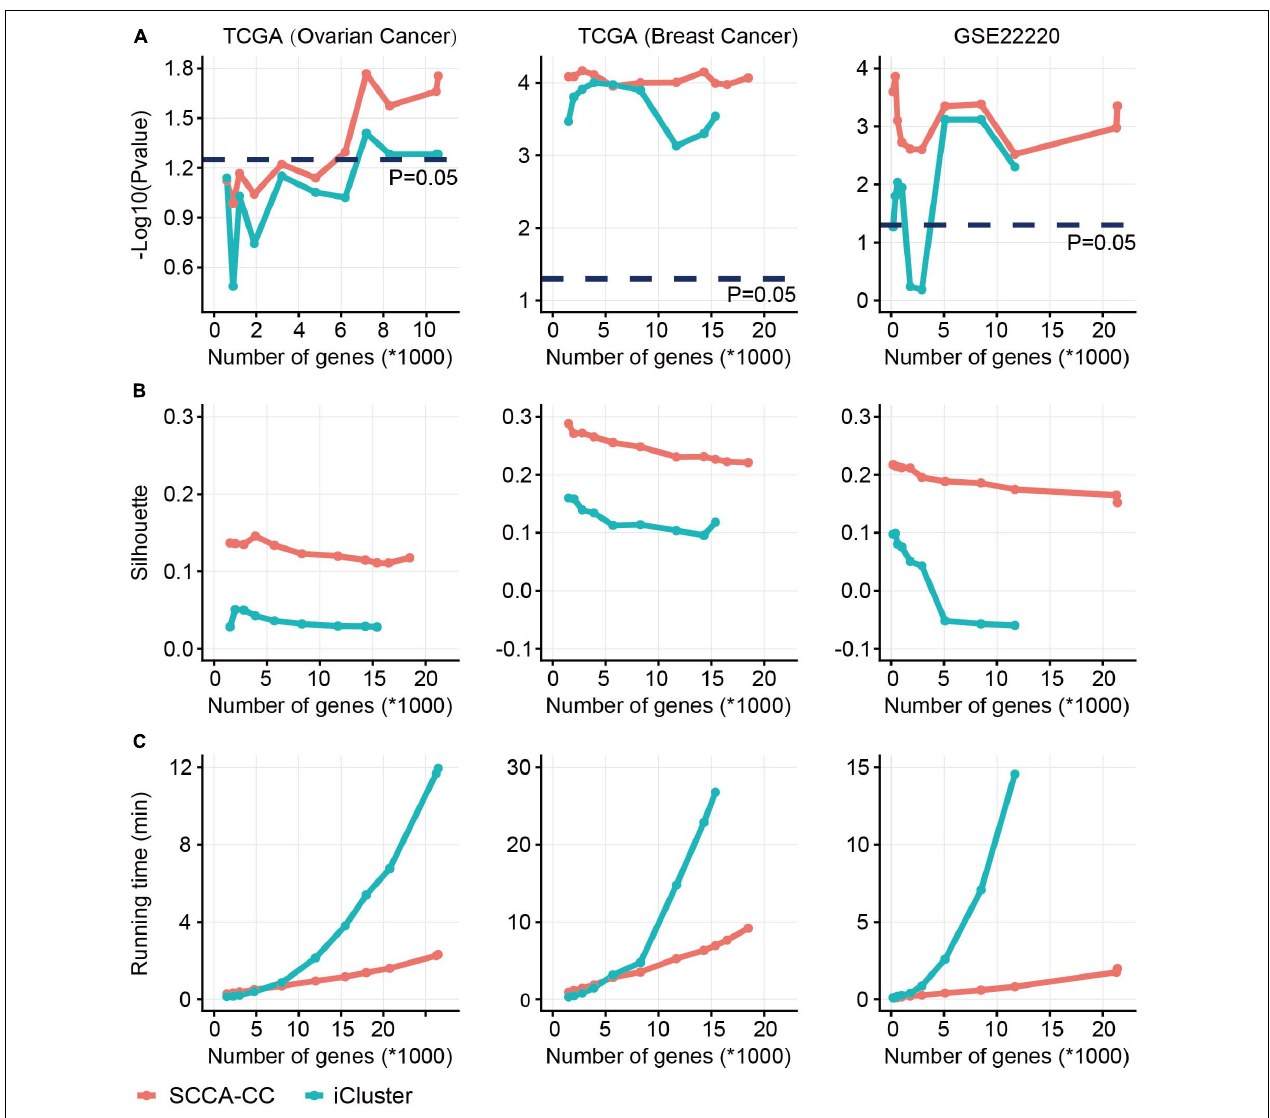
FIGURE 4 | A comparison of sparse canonical correlation analysis for cancer classification (SCCA-CC) with iCluster. Using varying numbers of genes preselected based on MAD, we compared the classification performance between SCCA-CC and iCluster based on (A) P- values indicative of association with survival calculated by log–rank tests, (B) Silhouette score representing the coherence of clusters, and (C) the algorithm running time evaluating the computational